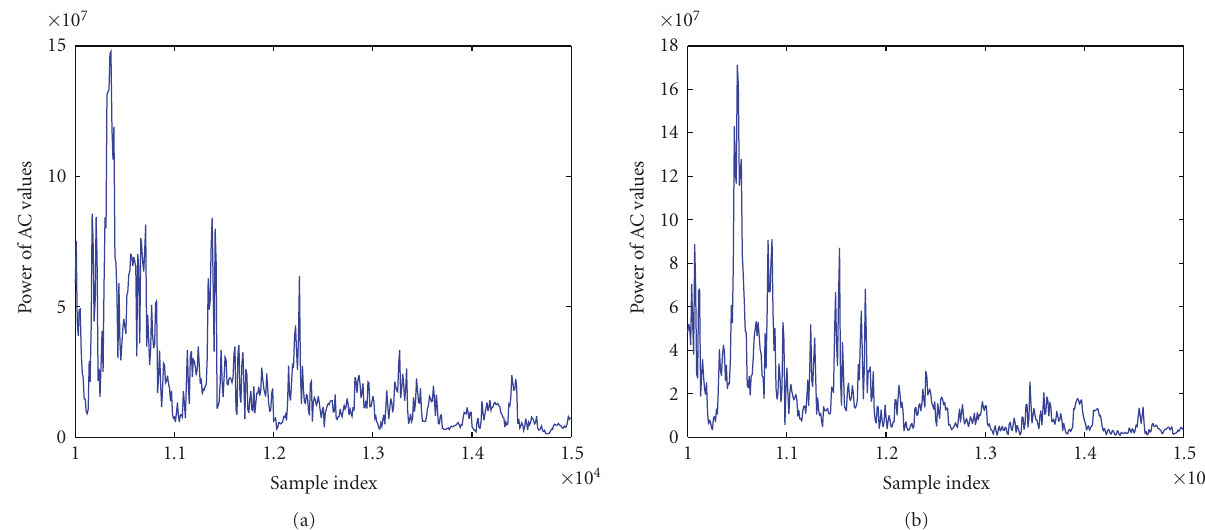
Figure 7: Power of AC values using MLE-based information integration and DCT. (a) No target (b) With target in the field.